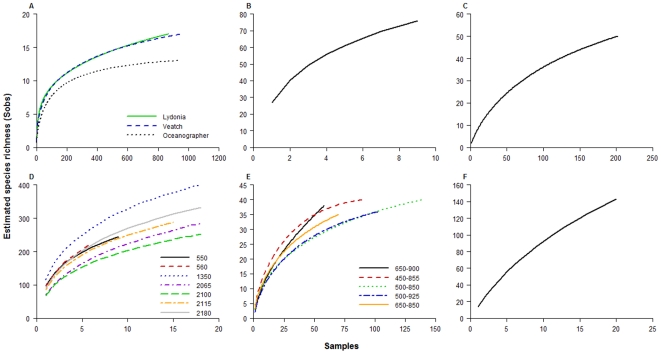
Estimated species richness (Sobs) curves by number of samples.(A) Canyon sub-region for epibenthic macro- and megafauna, as imaged in submersible photographs in Lydonia, Oceanographer and Veatch canyons in 1984 (data from [29]); Continental Rise sub-region for (B) demersal megafauna, collected from trawls using a 41′ Gulf of Mexico net between 2150–2650 m (data from [43], [44]), and (C) epibenthic and demersal macro- and megafauna, as imaged in submersible photographs between 2500–2600 m (data from Metaxas, unpublished); (D) Continental Slope sub-region for infaunal macrofauna sampled with box cores in 1983–84 at different depth stations (data from [26]); (E) NE Channel sub-region for epibenthic and demersal macro- and megafauna, as imaged in submersible photographs across different depths (data from Metaxas, unpublished); and (F) Seamount sub-region (Bear Seamount) for meso- and bathypelagic megafauna sampled using IGYPT nets, collected July 2002 (data from [30]).